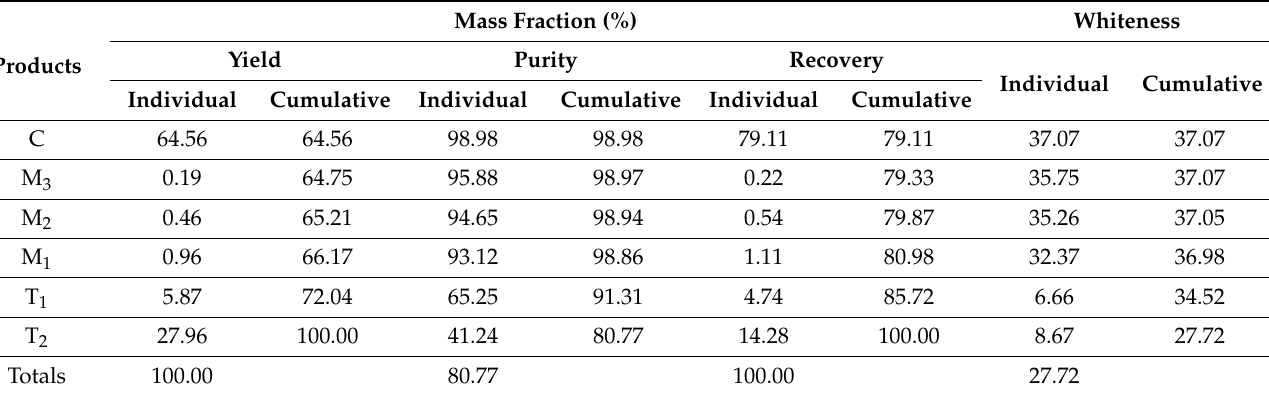
Figure 7. Cleaning test flowsheet of the recovery of gypsum from phosphogypsum. Table 4. Cleaning test results of recovering gypsum from phosphogypsum.